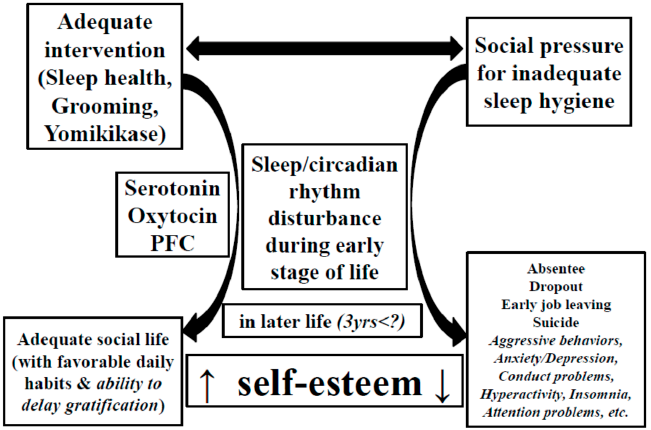
Figure 4. Proposed relationship between sleep hygiene, daily habits, neuronal elements, and